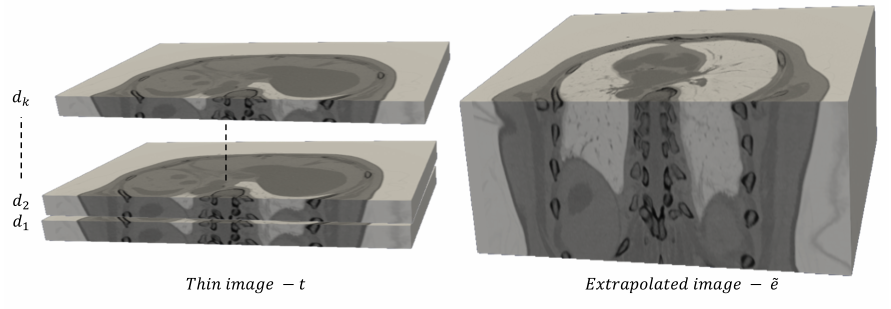
Figure 6. Position regression; left —thin slab t ; right —extrapolated volume ˜ e